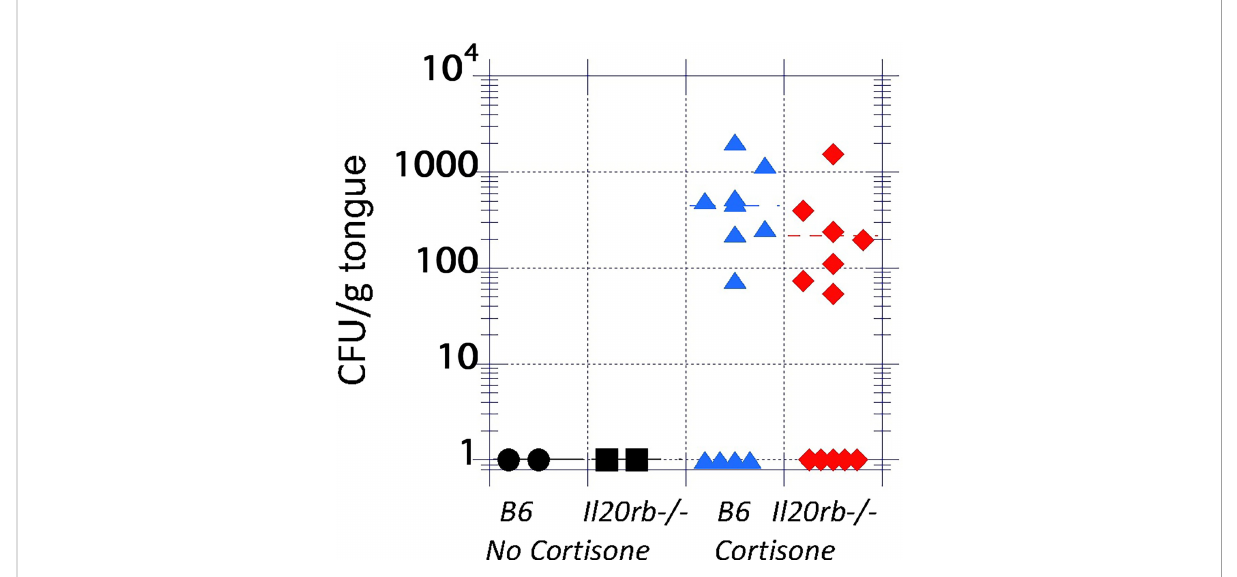
FIGURE 2 Fungal burdens in the tongues of untreated and immunosuppressed mice on Day 4 after inoculation with C. albicans strain CAF2-1. Infections were cleared in the absence of cortisone in both groups (black markers). In the presence of low-dose cortisone (17.5 mg/kg) to extend the infection, as previously described (Simpson-Abelson et al., 2015), the differences in fungal burdens between il20rb -/- (red diamonds) and wild- type B6 (blue triangles) mice were not statistically signi fi cant. Each marker represents one mouse. See the Materials and Methods section for a description of the statistical